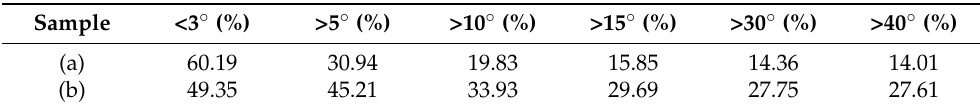
Figure 4. Orientation maps of bcc-phase in normal direction simulated CGHAZ with a heat input of 20 kJ/cm in the steel samples containing ( a ) 0.073% and ( b ) 0.110% Nb. Table 4. Percentage of different grain misorientation angles corresponding to samples shown in Figure 4.